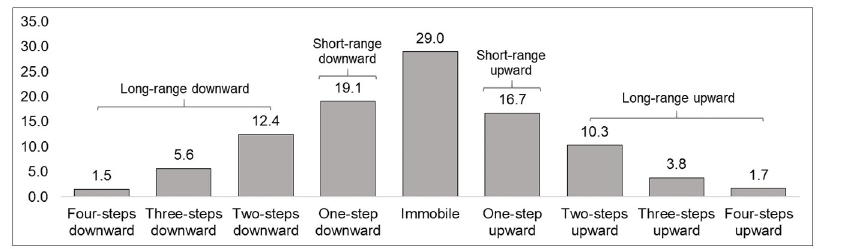
Fig 1. Social mobility trajectories. Note : Number of observations—4713.